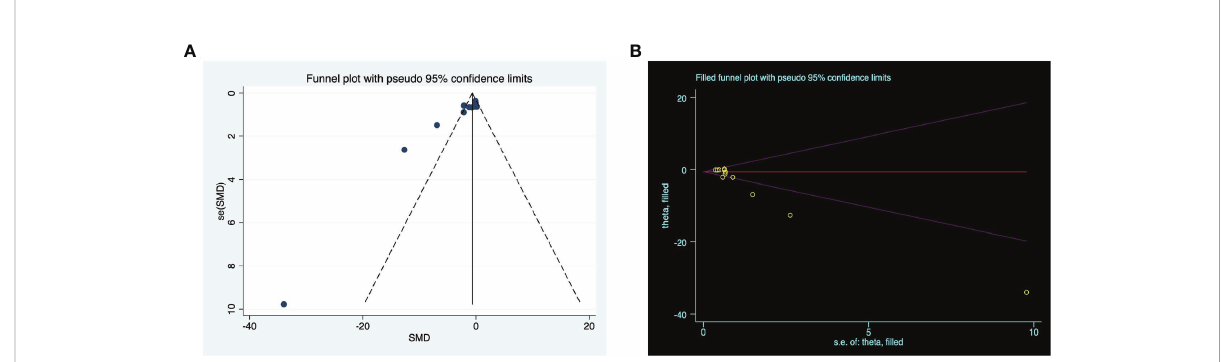
FIGURE 4 The evaluation of publication bias. (A) Funnel plots for clinical score, with the y-axis signifying study quality and the x-axis showing the study results. (B) Trim-and- fi ll method was used to evaluate the missing studies in clinical score. SMD, standardized mean